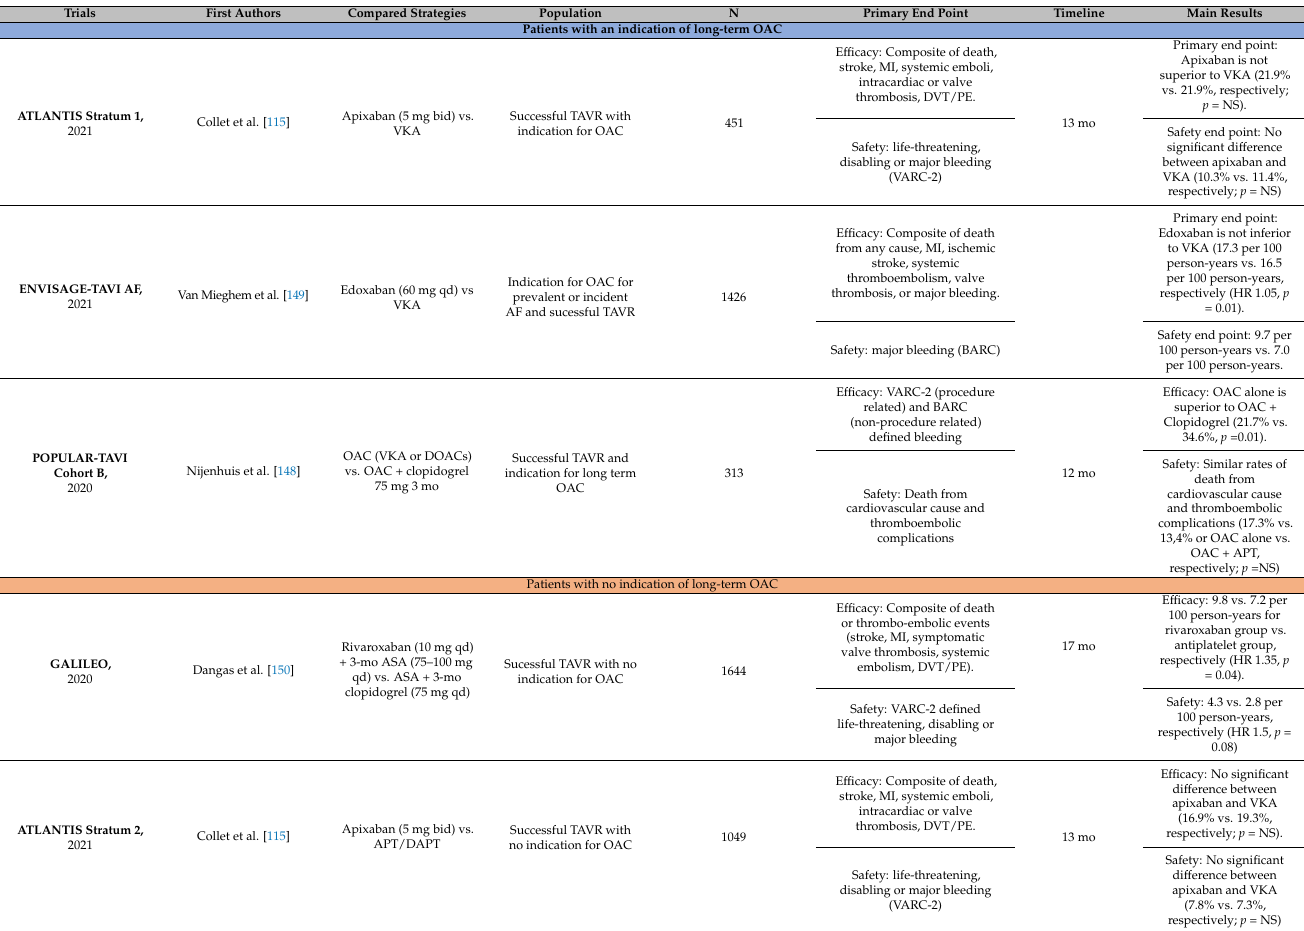
Table 2. RCTs Evaluating Antithrombotic therapy after